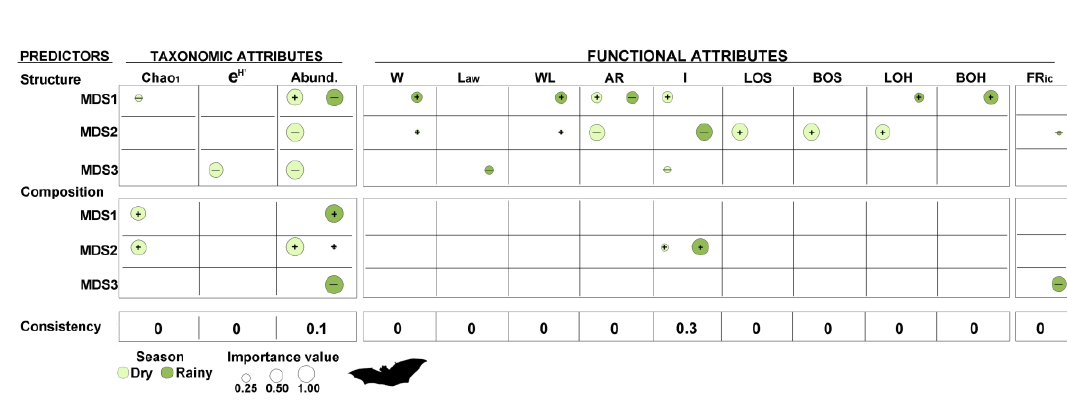
Figure 3. Vegetation attributes associated with variations on bat taxonomic and functional diversity during dry and rainy season. Bubble size corresponds to the degree of importance (importance value) of each predictor and bubble color corresponds to the season. The direction of each predictor effect is also shown on bubbles. The value quantifying seasonal consistency for variables associations is shown at the bottom of the chart. The chart only shows the information regarding those predictors included in the set of most plausible models. Response variables regarding taxonomic attributes of communities: the estimated species richness (Chao 1 ), the exponential of Shannon index (e H ), and the overall abundance of bats (Abund.). Response variables regarding functional attributes of communities: the community-weighted mean value for the weight (W), the arm-wing length (L aw ), the wing loading (WL), the aspect-ratio (AR), the wing tip index (I), the length of the spear (LOS), the breadth of the spear (BOS), the length of the horseshoe (LOH), the breadth of the horseshoe (BOH), and the functional richness index (FRic). Vegetation predictors: scores of NMDS axis summarizing site variation on vegetation structural complexity (Structure) and on species composition (Composition).